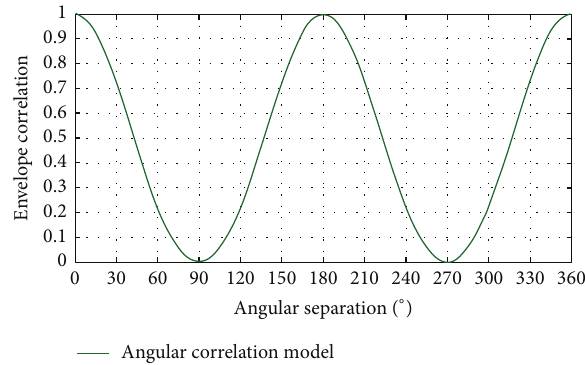
Figure 1: Angular correlation for two dipole antennas using the empirical